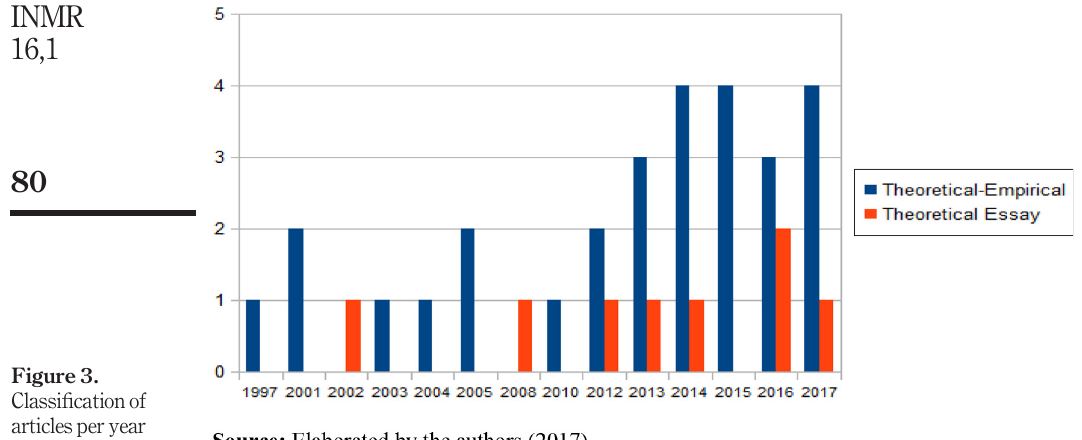
Figure 3. Classi fi cation of articles per